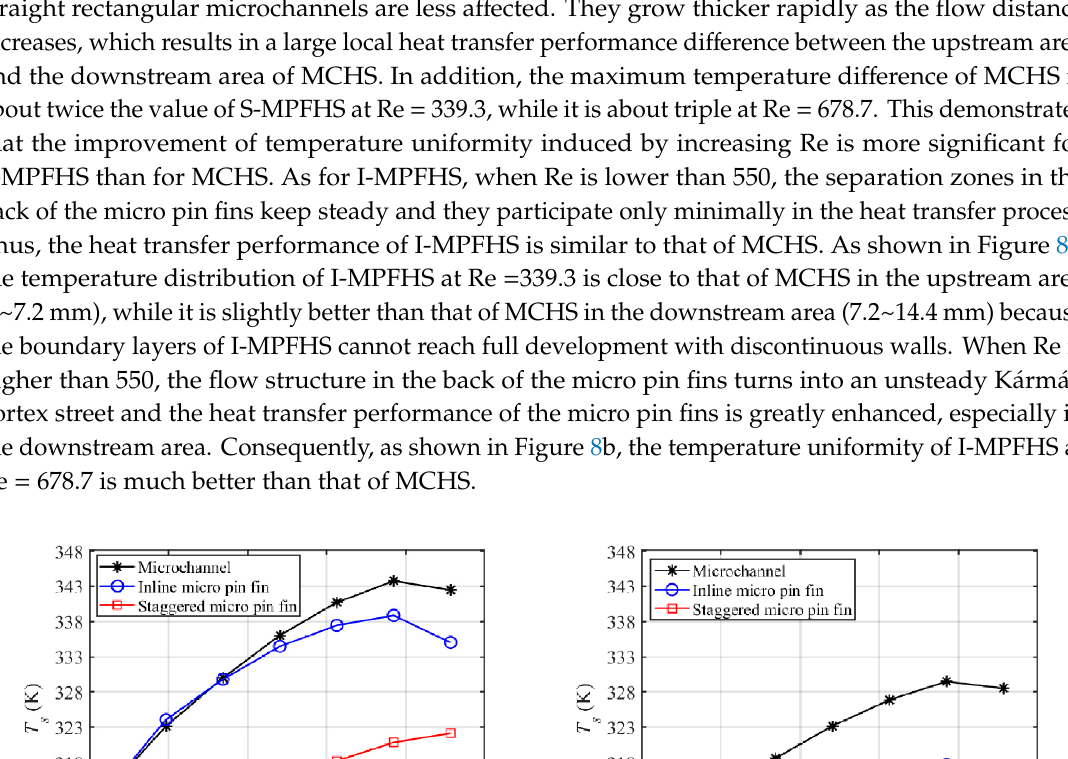
Figure 9. Variations of the pressure drop with the Reynolds number.